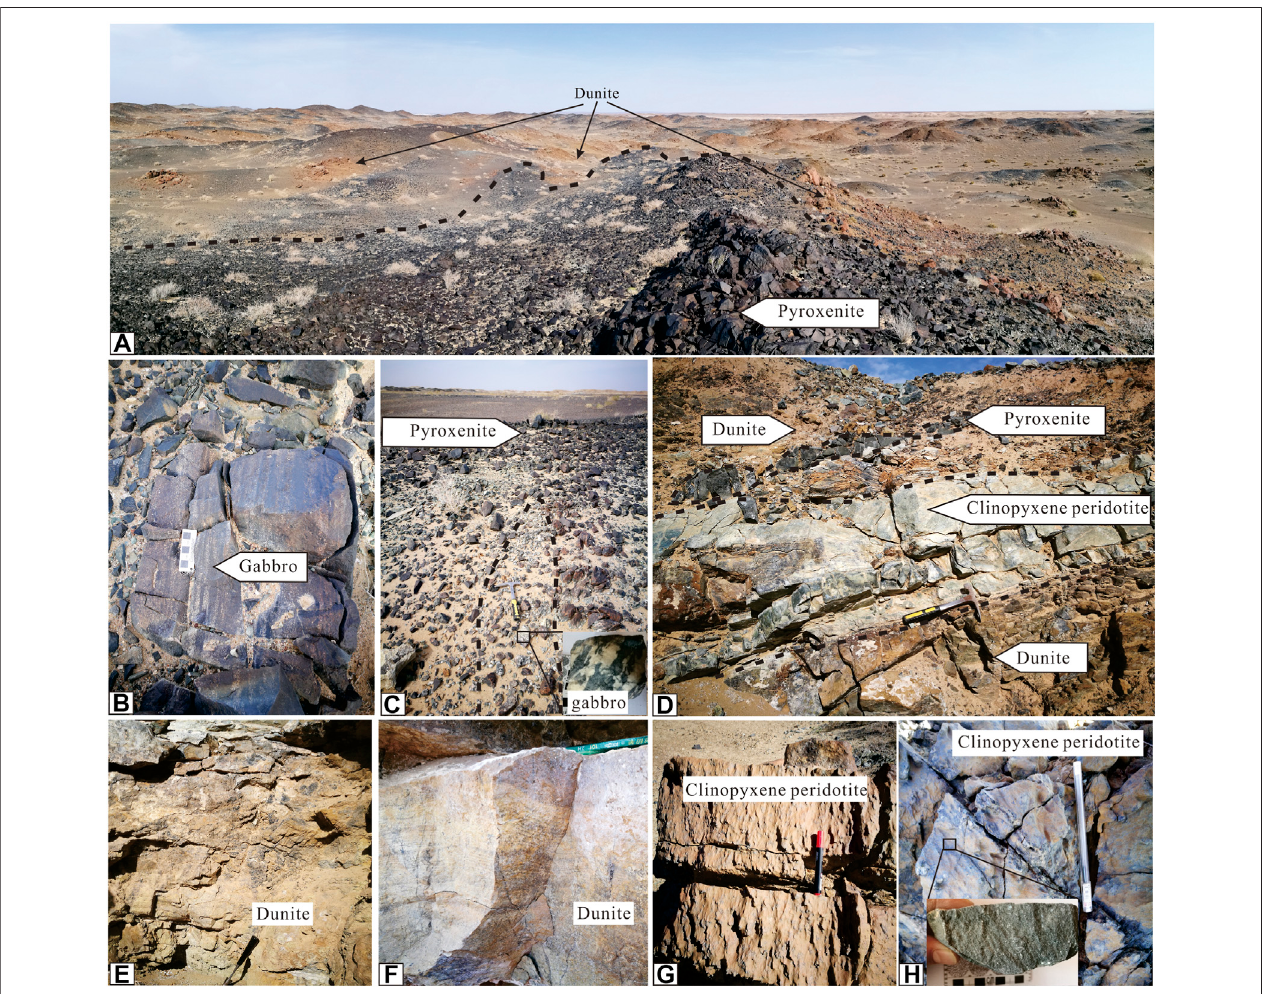
FIGURE 3 | Field photographs of Hongshishan ultrama fi c – ma fi c complex. (A) Dunites are intruded by pyroxenite; (B) Gabbro with the rhythmic layering of clinopyroxene and plagioclase, showing the magmatic fractional crystallization; (C) Coarse grain gabbro dyke intruded into pyroxenite; (D) Dunite layers alternating with clinopyroxene peridotite, pyroxenite layer; (E) The light yellow dunites contain chromites; (F) Dunite showing typical cumulate textures and small-scale layering features (0.2 – 0.6 cm); (G, H) Clinopyroxene peridotites were weathered red with nodular appearances.